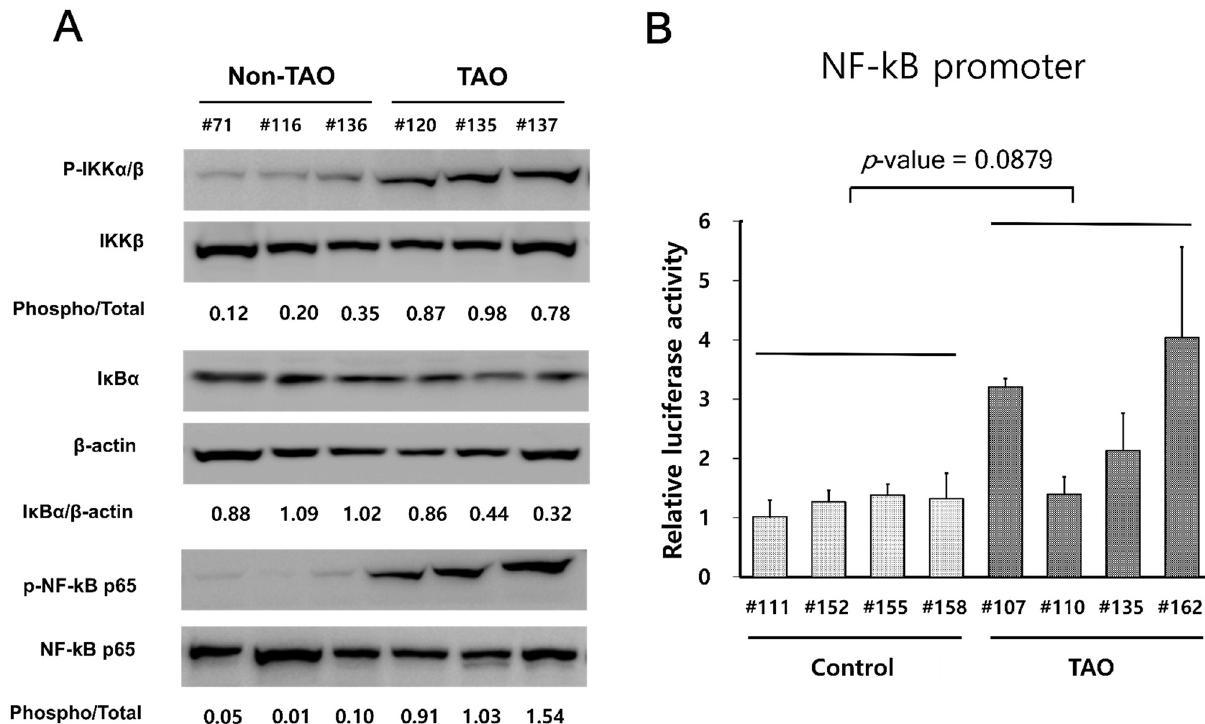
Fig 4. OFs from patients with TAO showed higher levels of NF- κ B activity. (A) OFs were plated at a concentration of 2 x 10 5 cells/well in a 6-well plate. After 24 hours, NF- κ B activity in OFs from control individuals (#71, #116, #136) and patients with TAO (#120, #135, #137) was determined by measuring the levels of degradation of I κ B and phosphorylation of IKK α / β and NF- κ B p65 via a Western blot analysis. (B) OFs from control individuals (#111, #152, #155, 158) and patients with TAO (#107, #110, #135, #162) were co-transfected with pGL4.32[luc2P/NF- κ B-RE/Hygro] for firefly luciferase and pRL-TK for renilla luciferase. After 24 hours, cell extracts were assayed for firefly and renilla luciferase activity. The results are expressed as the ratio of firefly-to-renilla luciferase activity (Fluc/Rluc).